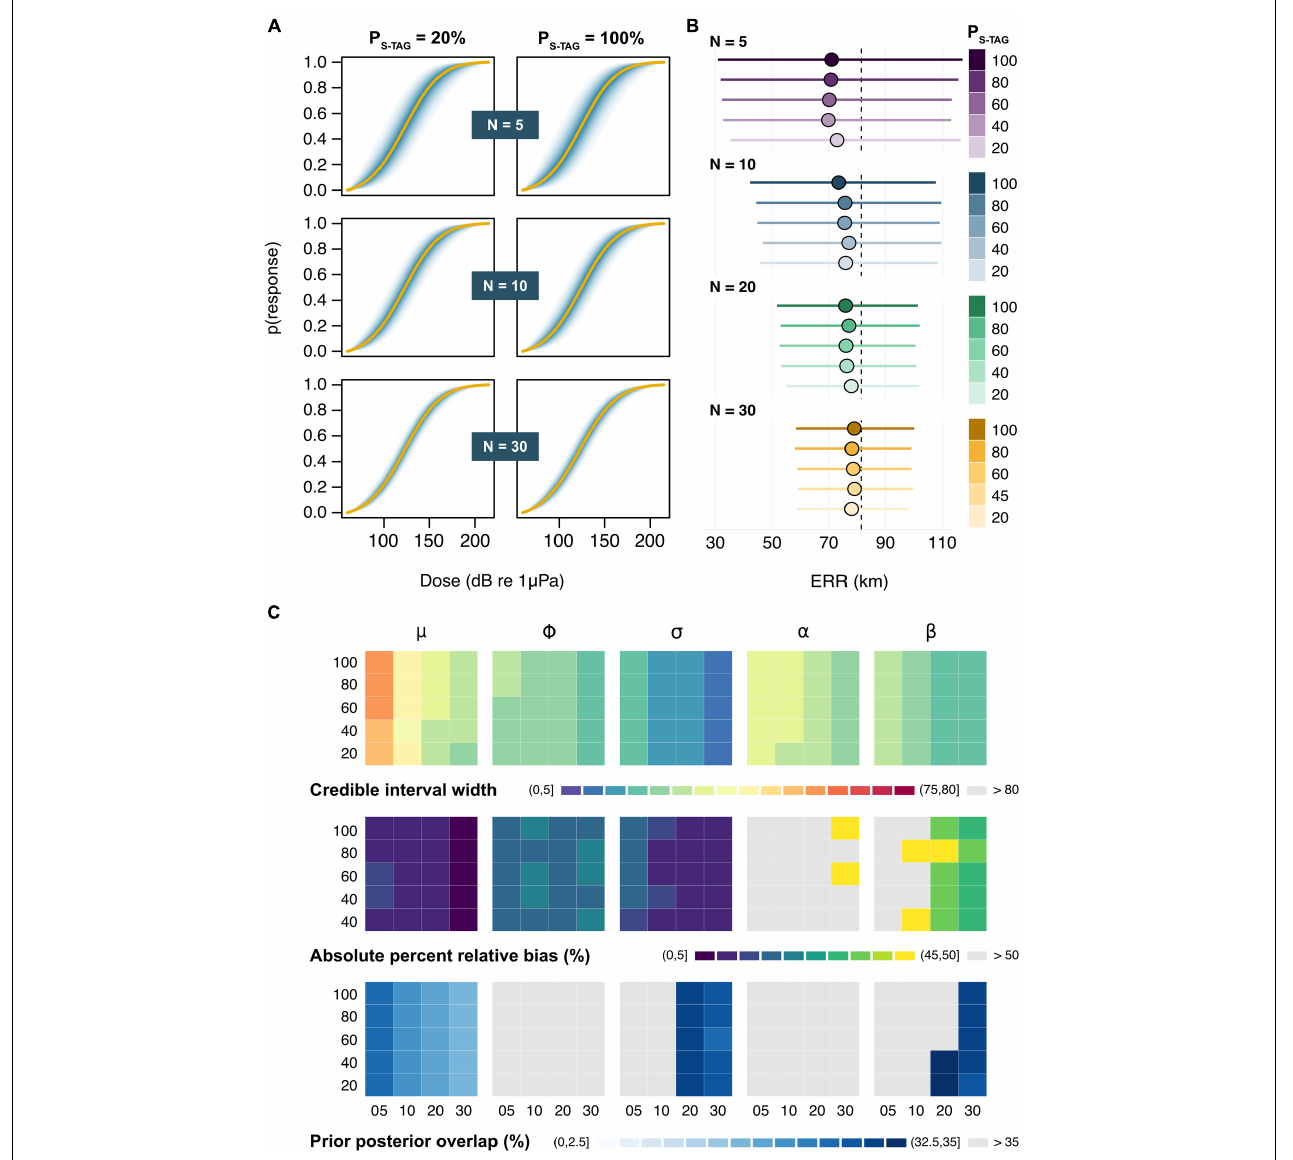
FIGURE 4 | Outputs from the full model. (A) Example dose-response curves for a subset of sample sizes (N) and ratios of satellite tags (P S − TAG ). Solid lines represent the average posterior medians across Ns = 100 simulations, followed by the average 5, 10, 15 ... and 95% credible intervals in darker to lighter shades of blue. (B) Posterior estimates of the effective response range (ERR). Circles and bars respectively denote the average posterior median and credible intervals for each N × P S − TAG combination. The dashed line marks the true underlying value. (C) Summary of patterns in the precision, accuracy, and identifiability of posterior estimates across N (across) × P S − TAG (down) combinations. Results are shown (from left to right) for the location parameter relating to mean response threshold for all whales ( µ ), the scale parameters relating to the between-whale variation ( φ ) and the within-whale between-exposure variation ( σ ), and the two contextual covariates ( α and β ). Rows indicate the average posterior credible interval width (in dB) [top], absolute percent relative bias (in %) [middle], and prior posterior overlap (PPO, in %) [bottom]. PPO values above 35% indicate that parameters may be non-identifiable (Gimenez et al.,